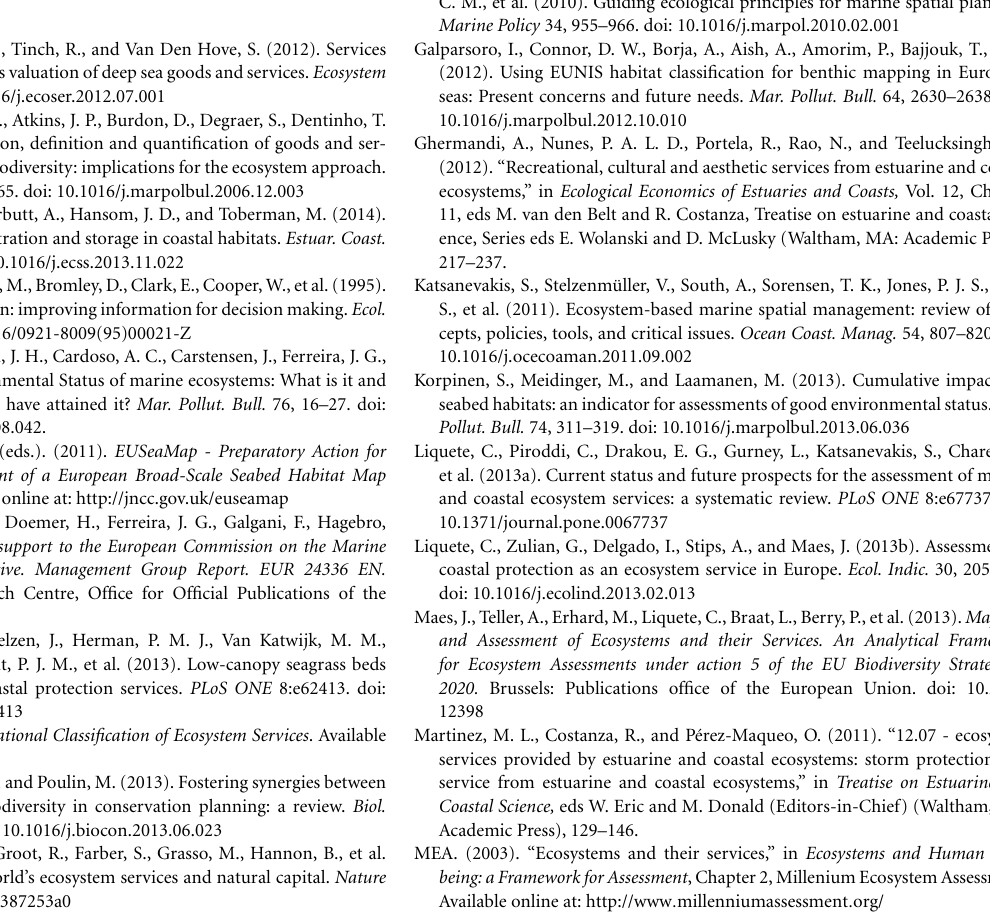
Figure S1 | Depth distribution of the Exclusive Economic Zone (dark blue) and depth distribution of habitat-mapped areas (light blue), in the four subregions of the European North Atlantic Ocean; (A) Macaronesia; (B) Bay of Biscay and Iberian Coast; (C) Celtic Seas; and (D) Greater North Sea, including the Kattegat, the English Channel and Norway. Figure S2 | Spatial distribution of food provision services. Figure S3 | Spatial distribution of raw materials (biological, incl. biochemical, medicinal, and ornamental) services. Figure S4 | Spatial distribution of air quality and climate regulation services. Figure S5 | Spatial distribution of disturbance and natural hazard prevention services. Figure S6 | Spatial distribution of photosynthesis, chemosynthesis, and primary production services. Figure S7 | Spatial distribution of nutrient cycling services. Figure S8 | Spatial distribution of reproduction and nursery services. Figure S9 | Spatial distribution of maintenance of biodiversity services. Figure S10 | Spatial distribution of water quality regulation and bioremediation of waste services. Figure S11 | Spatial distribution of cognitive value services. Figure S12 | Spatial distribution of leisure, recreation, and cultural inspiration services. Figure S13 | Spatial distribution of feel good or warm glow